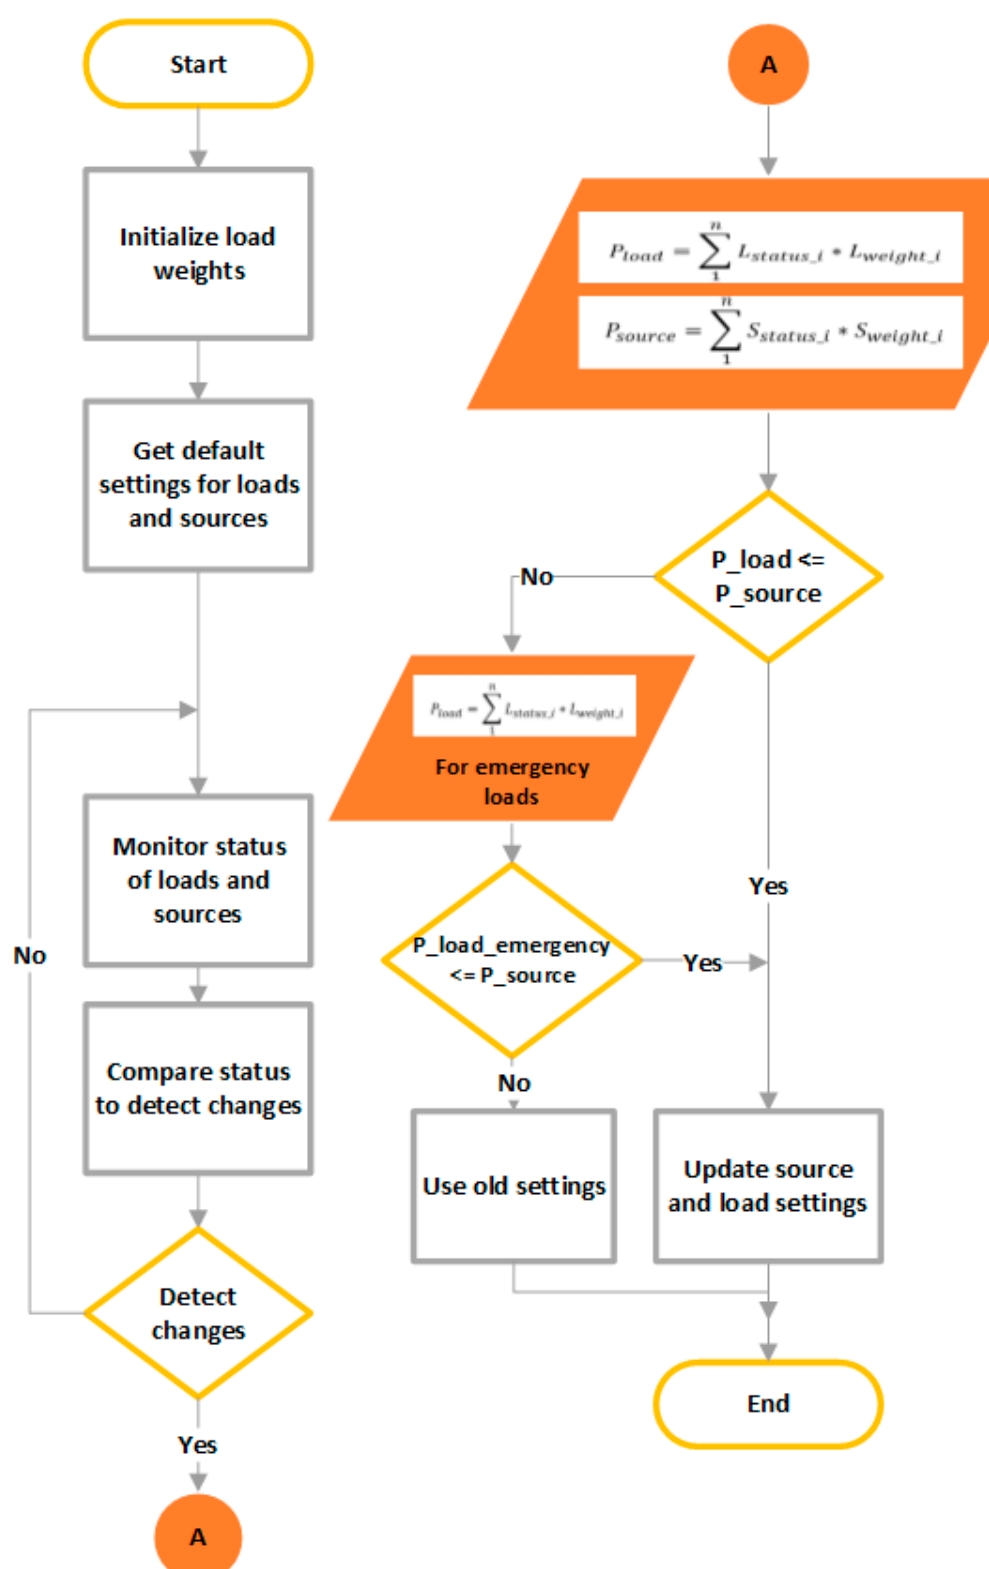
Figure 3. Fail-safe algorithm of the